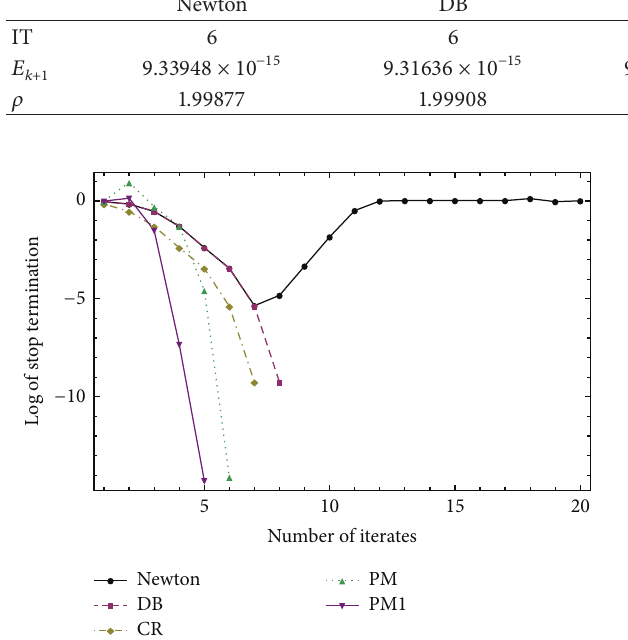
Figure 1: The comparison of different methods for finding 𝐴 1/2 in Example